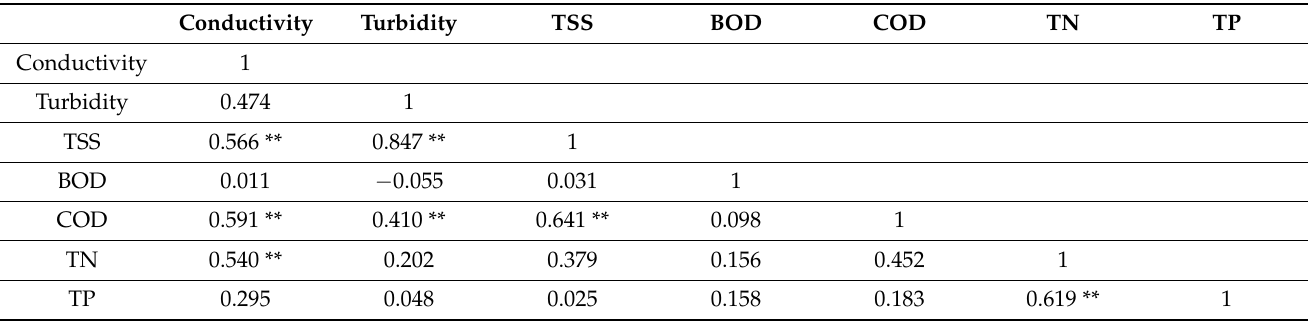
Table 4. Correlation analysis of inflow water quality parameters in the infiltration